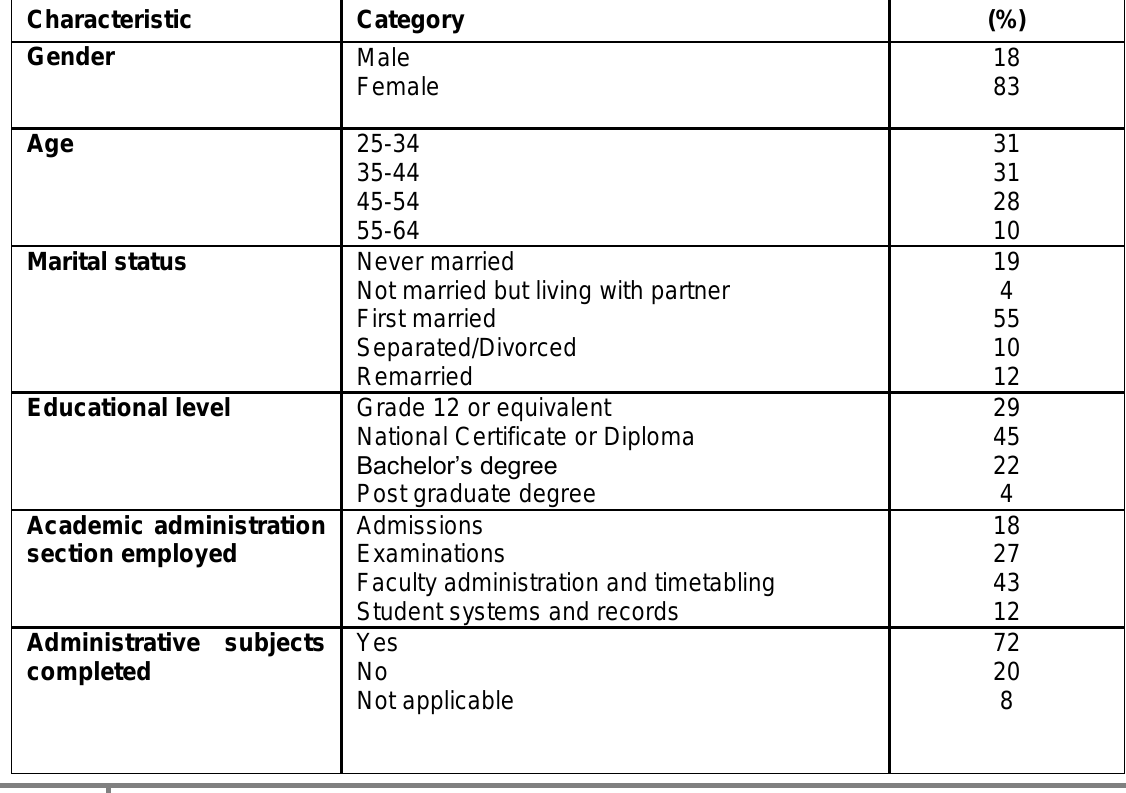
Frequency distribution results: A respondent